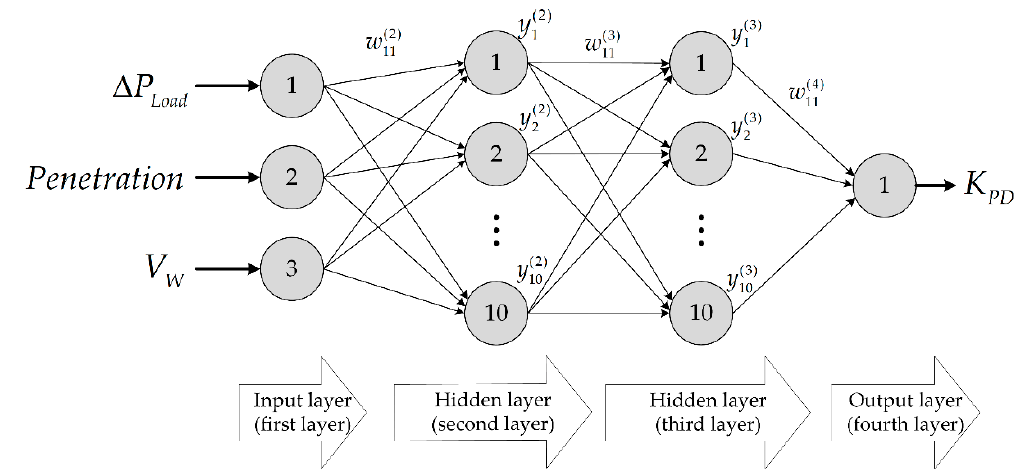
Figure 7. ANN for a frequency controller. ∆ P Load : load disturbance.